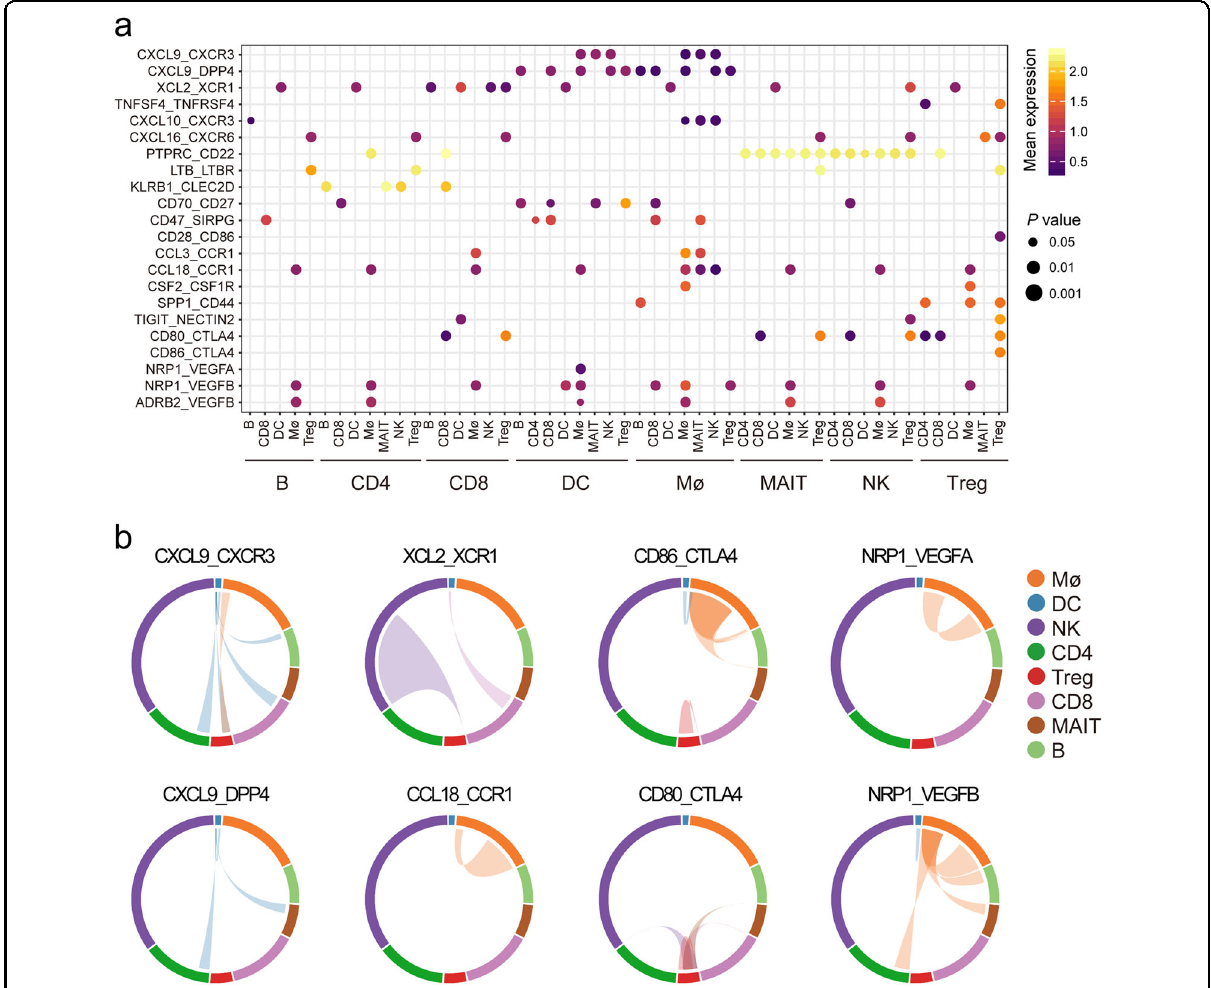
Fig. 6 Increased cell – cell interactions occurring in the HCC TME. a Overview of selected ligand – receptor interactions which presented speci fi cally in HCC tumors. P values indicated by circle size (permutation test). The means of the average expression level of interactions are indicated by color. The cell types below the line are the ligand cells, and the cell types above the line are the corresponding receptor cells. b Selected interactions of ligand-receptor pairs in HCC TME. The line color indicates ligands broadcast by the cell population of the same color. Lines connect to cell populations where cognate receptors are expressed. The line thickness is proportional to the number of ligands where cognate receptors are present in the recipient cell